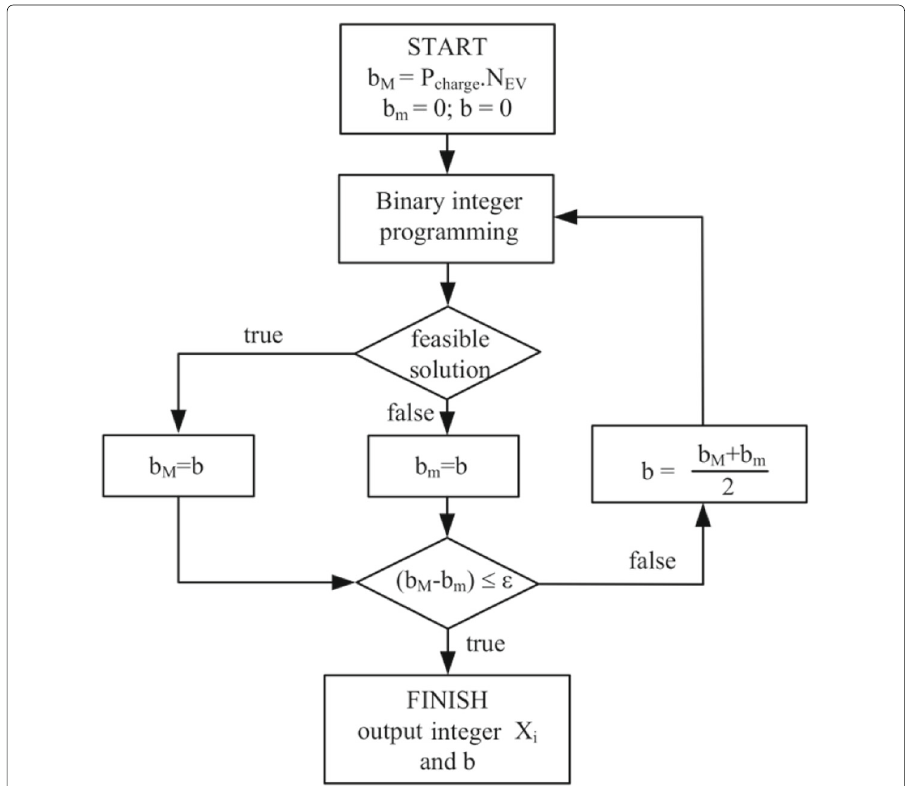
Fig. 1 Bisection Scheme